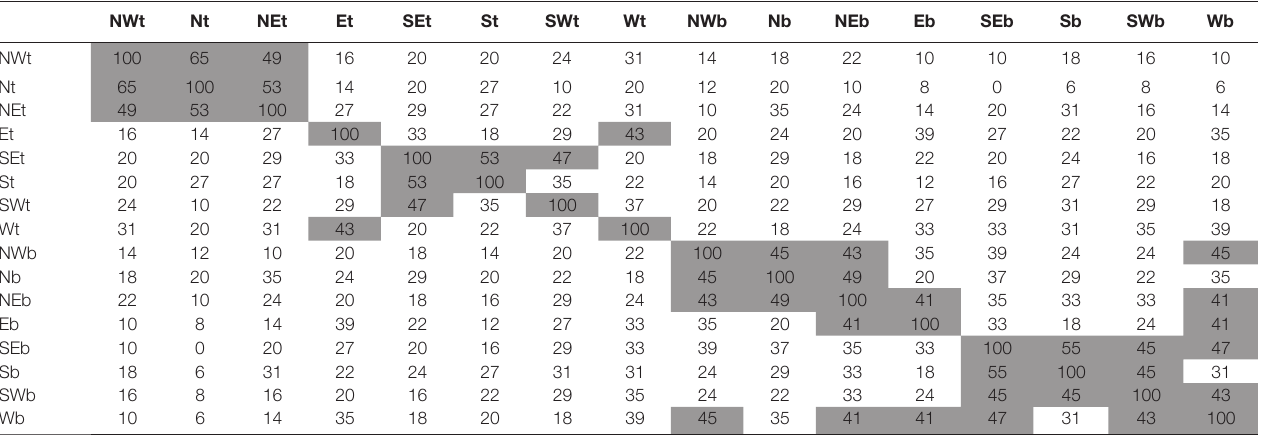
TaBle 7 | Co-clustered movement directions across